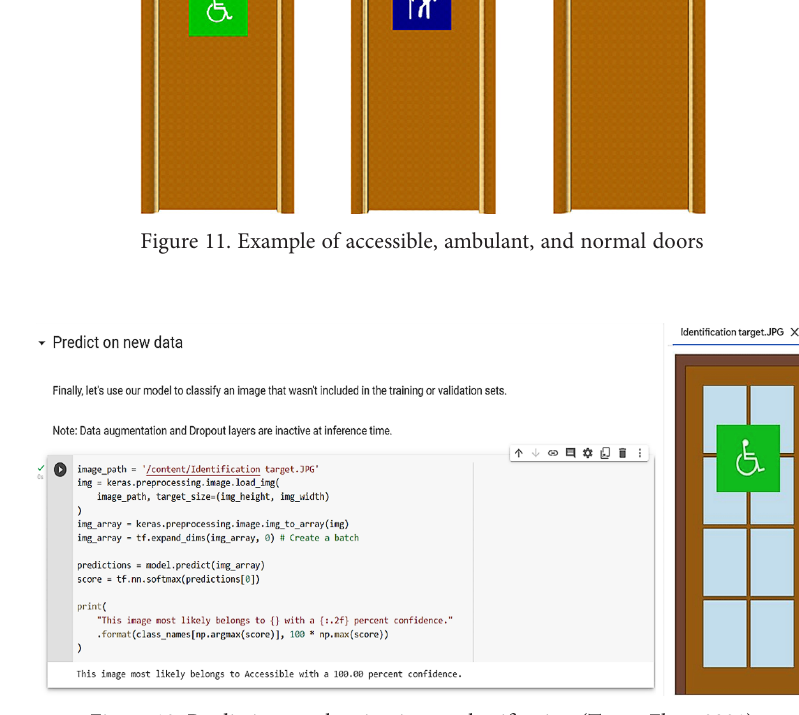
Figure 12. Prediction result using image classification (TensorFlow,